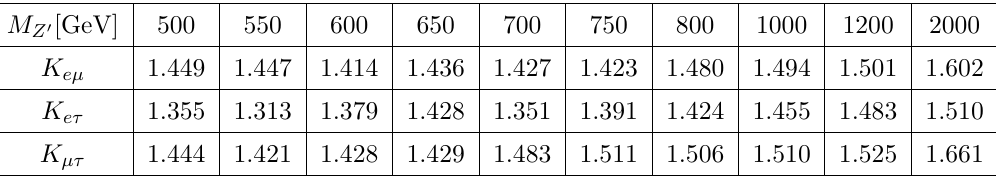
Table 1 . NNLO K -factors from SSM Z 0 .